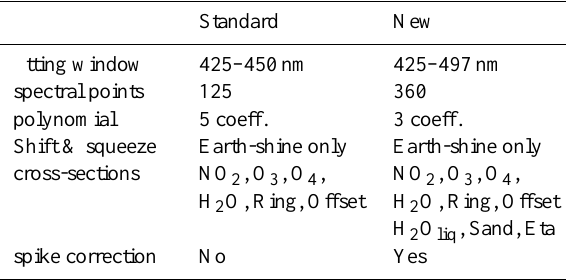
Table 1. Overview on settings for the standard and improved NO 2 retrieval. Eta is a calibration function representing the polarisation sensitivity of the GOME-2